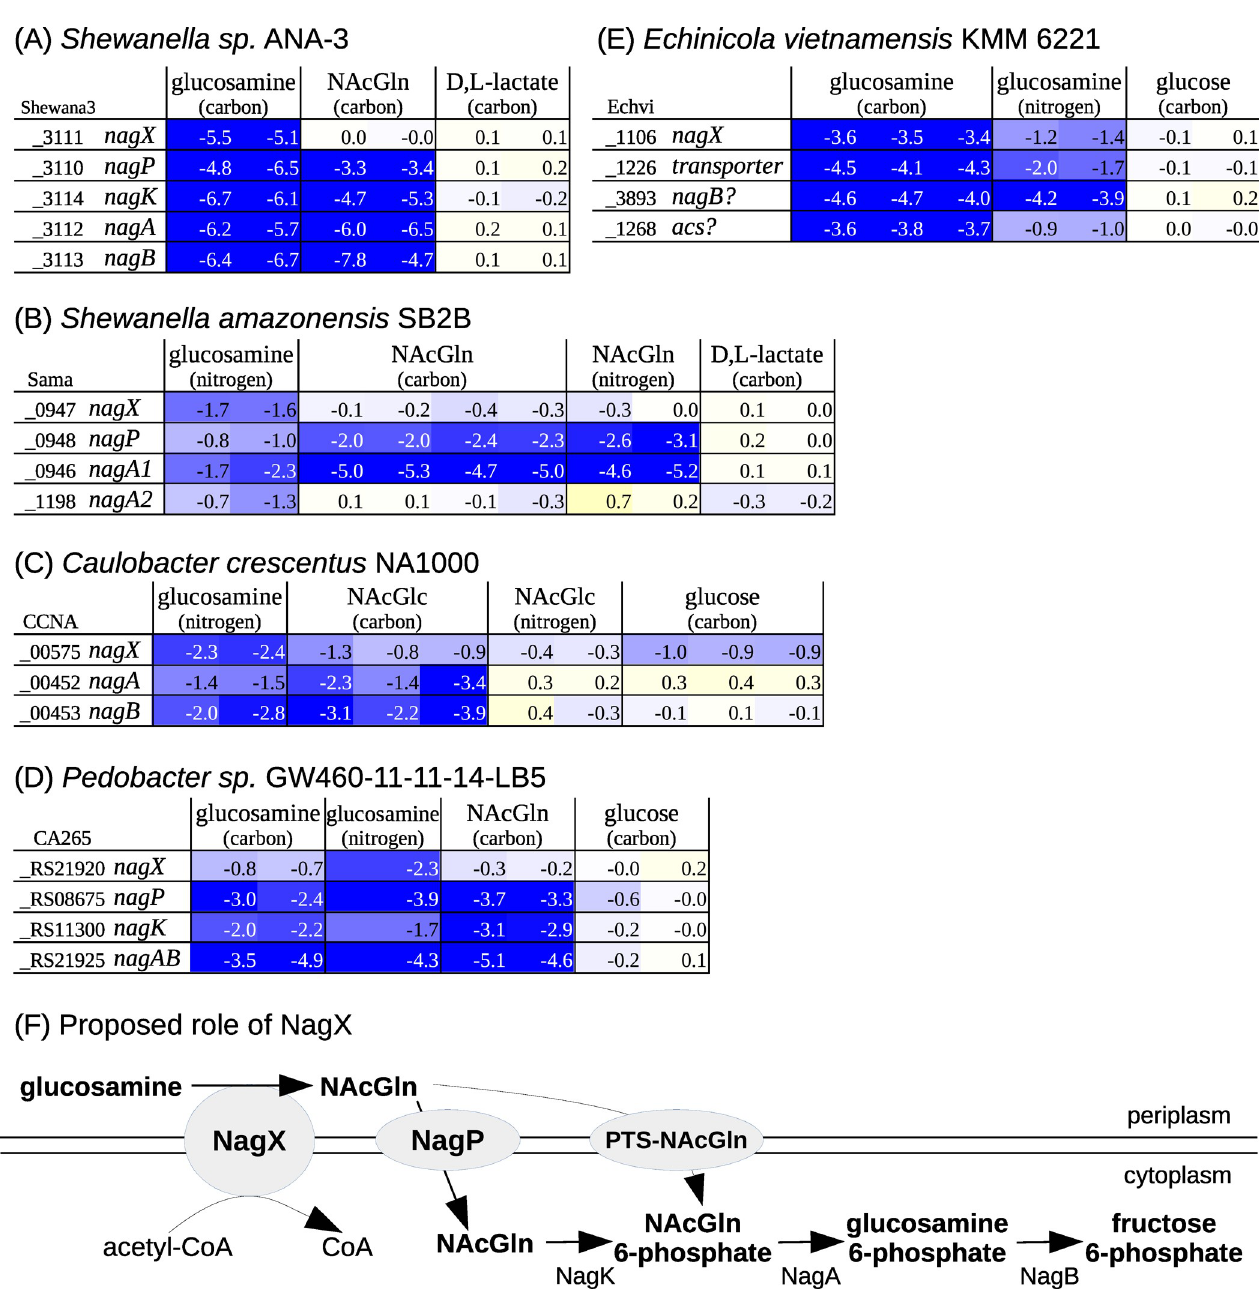
Fig 3. Role of NagX in glucosamine utilization. (A-E) Fitness data from five different bacteria with glucosamine or NAcGln as the sole source of carbon or nitrogen. As a control, we also show fitness with D,L-lactate or glucose as the carbon source. Each colored cell shows the fitness value for a gene in an individual experiment. The fitness of a gene is the log2 change in the relative abundance of mutants in that gene during 4–8 generations of growth (from inoculation at OD 600 = 0.02 until saturation). Cells with strongly negative fitness are dark blue. (F) The proposed role of NagX.